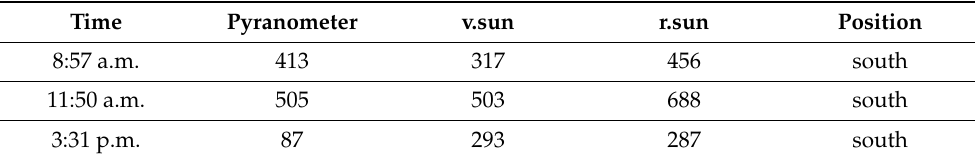
Figure 7. Solar irradiance at the State Theatre on 23 June 2021 (W/m 2 ) at ( A ): 8:57 a.m., ( B ): 11:50 a.m., and ( C ): 3:31 p.m. The black circle represents the measurement location. Table 3. Solar irradiance at the State Theatre in W/m 2 on 23 June 2021.